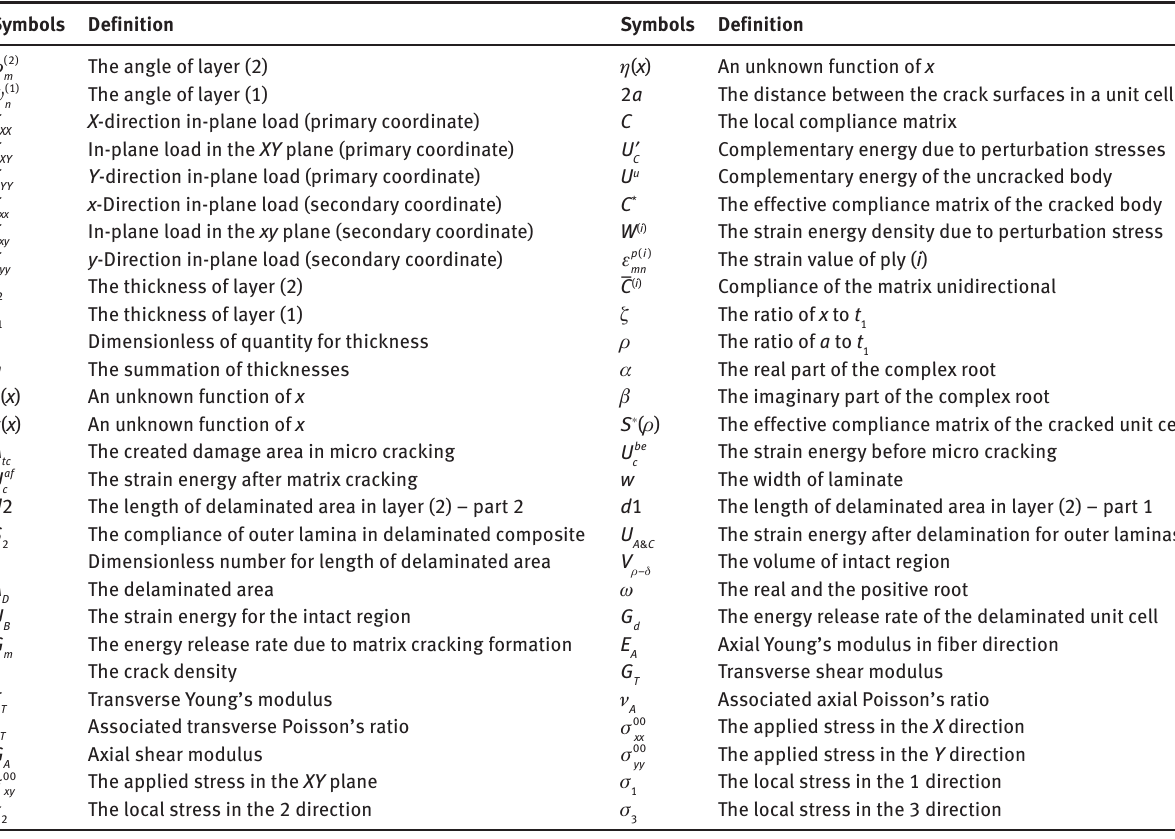
Table 1: A list of parameters and their definitons in the text. Symbols Definition Symbols Definition